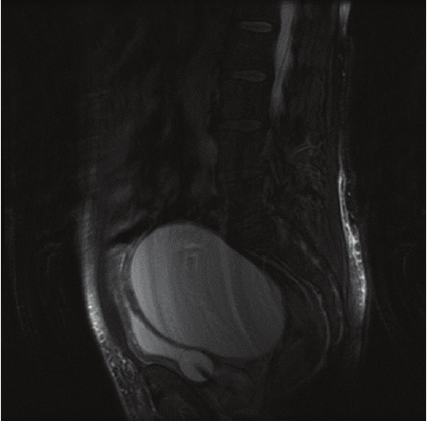
Figure 5: Uro-NMR: retrovesical 12 × 14cm mass cranial to the prostate and seminal vesicles and without communication with the